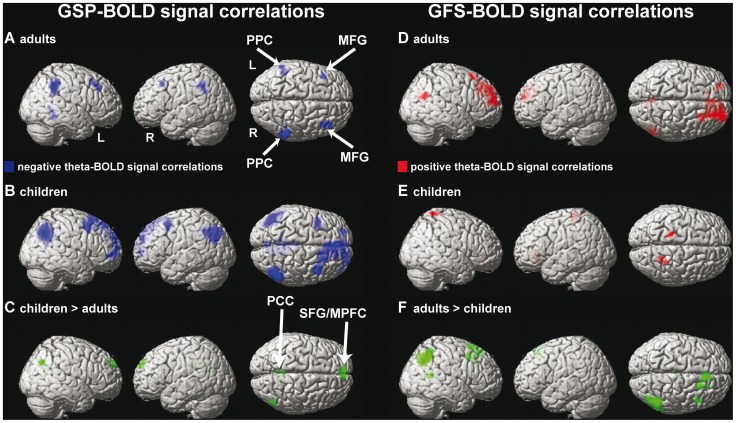
Theta GSP-BOLD and GFS-BOLD signal correlations.Within-group results for theta GSP-BOLD signal correlations are shown in A-C, while GFS-BOLD signal correlations are shown in D-F. Between-group comparisons are presented in C and F. For all subfigures, results are shown at p<0.001 (uncorrected), except for subfigure E (p<0.01, uncorrected). Abbreviations: PPC, posterior parietal lobe; MFG, middle frontal gyrus; MPFC, medial prefrontal cortex; PCC, posterior cingulate cortex, R, right hemisphere; L, left hemisphere.